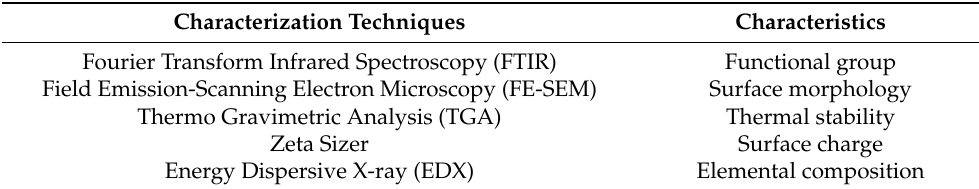
Table 5. Characterization techniques used for hydrogel adsorbent and information obtained from the characterization